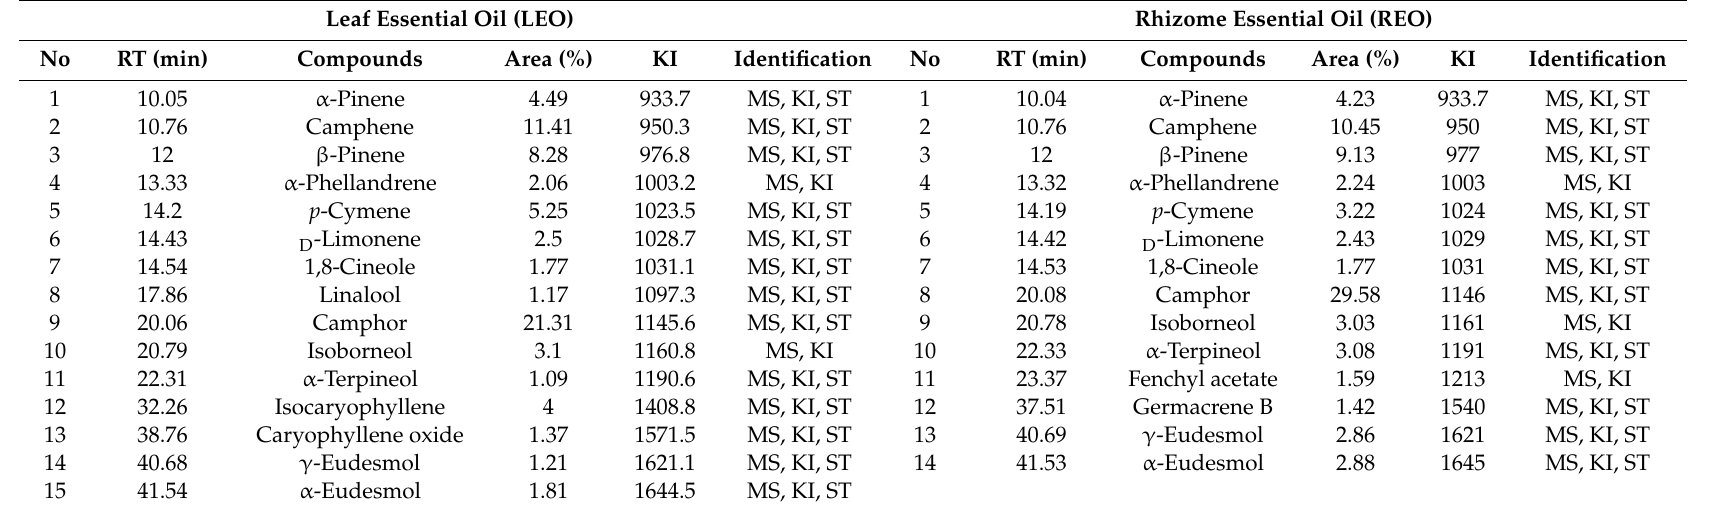
Table 1. The major components and their relative contents (%) of leaf and rhizome essential oils of Alpinia nantonensis . Leaf Essential Oil